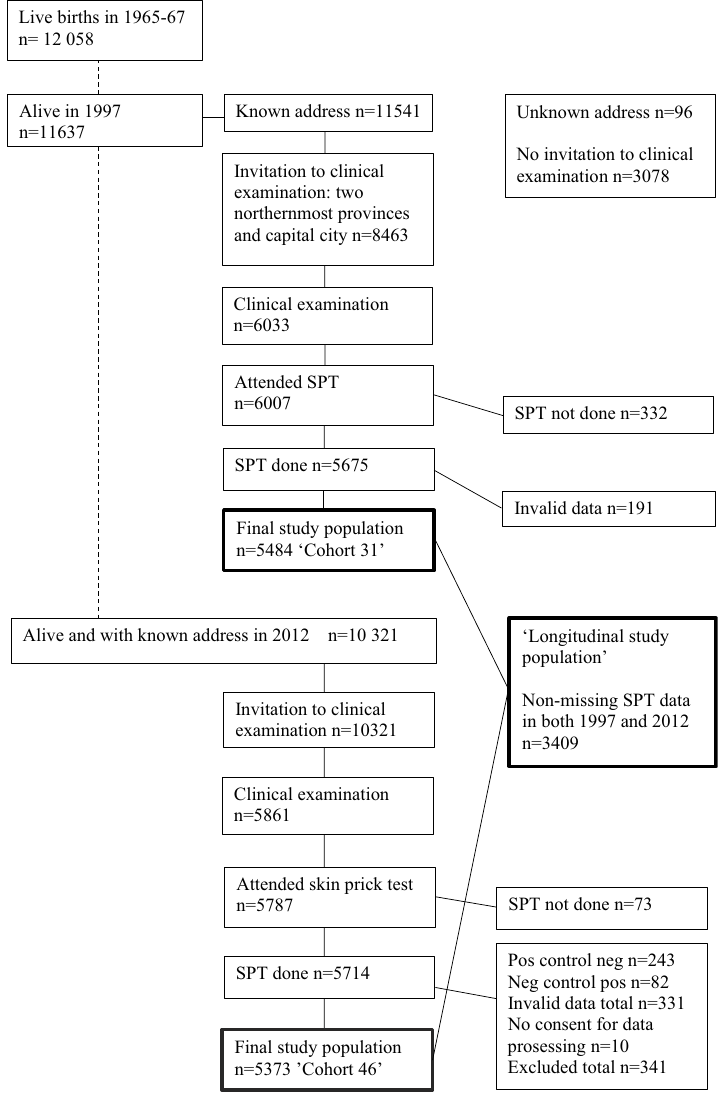
Figure 2. Flow chart of the NFBC 1966 population: follow-up visits including skin prick tests